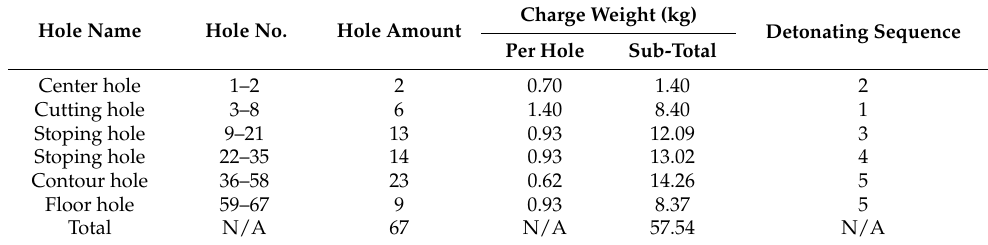
Table 6. Blasting parameters of the optimized